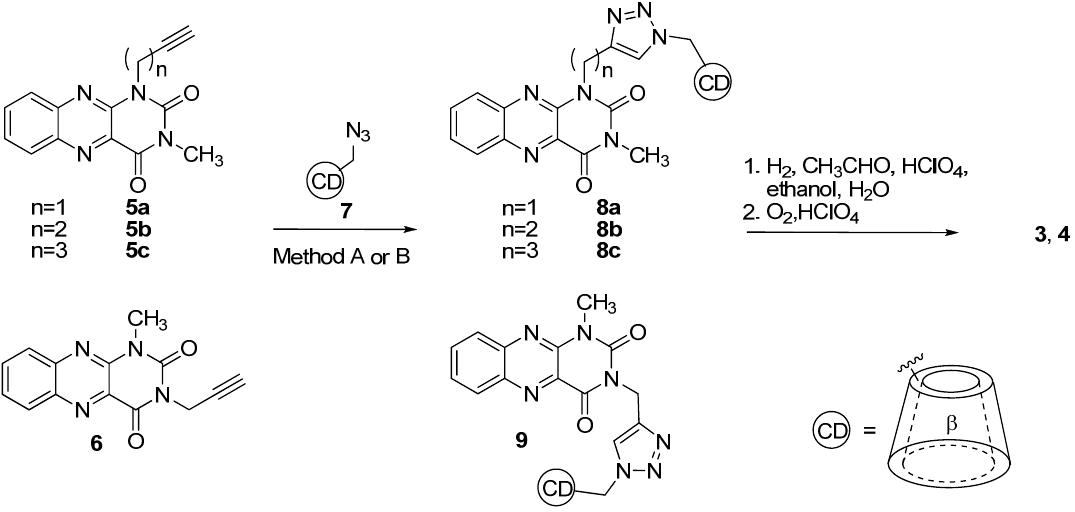
Table 1. Click reaction between flavins 5 or 6 and azidocyclodextrin 7 a